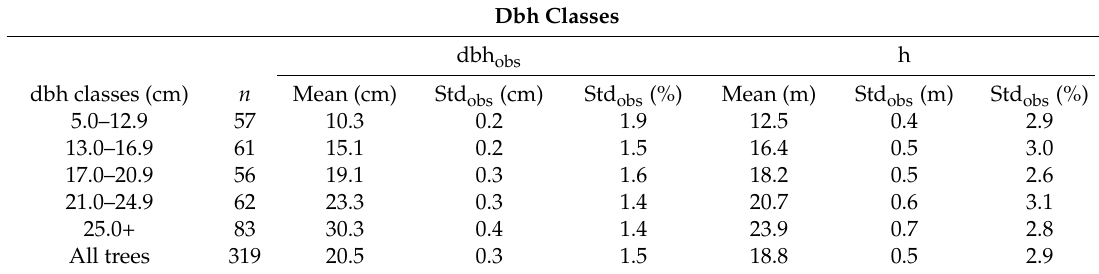
Table 6. The mean dbh obs (mean of cross measurements) and h (height) of the five tree size classes that are based on the dbh, as well as the class ‐ wise means of standard deviations (std obs ) calculated from the four observations of dbh obs and h.